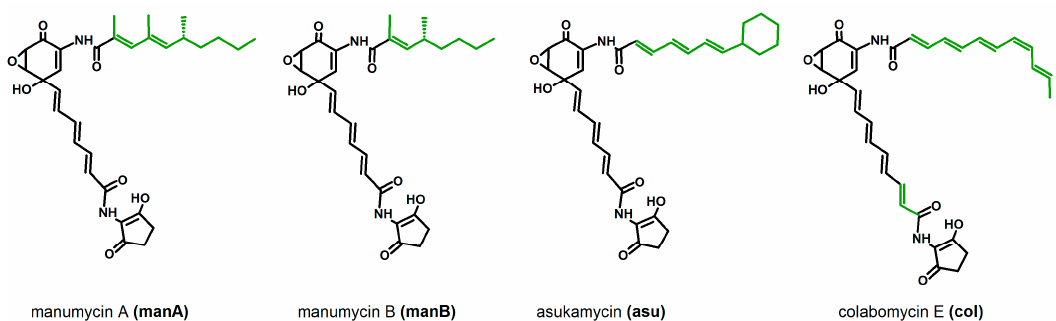
Figure 1. Structures of manumycin-type metabolites used in the study. Variable parts of molecules are shown in green. Manumycin A and B are produced by Streptomyces parvulus Tü64, asukamycin by Streptomyces nodosus ssp. asukaensis, and colabomycin E by Streptomyces aureus SOK1/5-04.